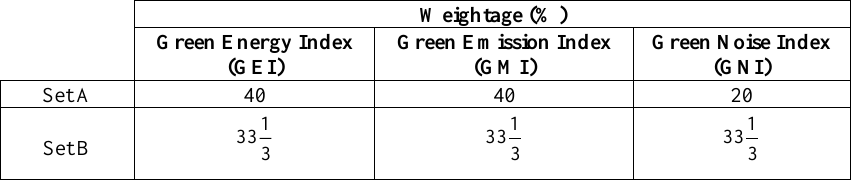
Table 4. Two sets of weightage in assessing Green Performance Index .